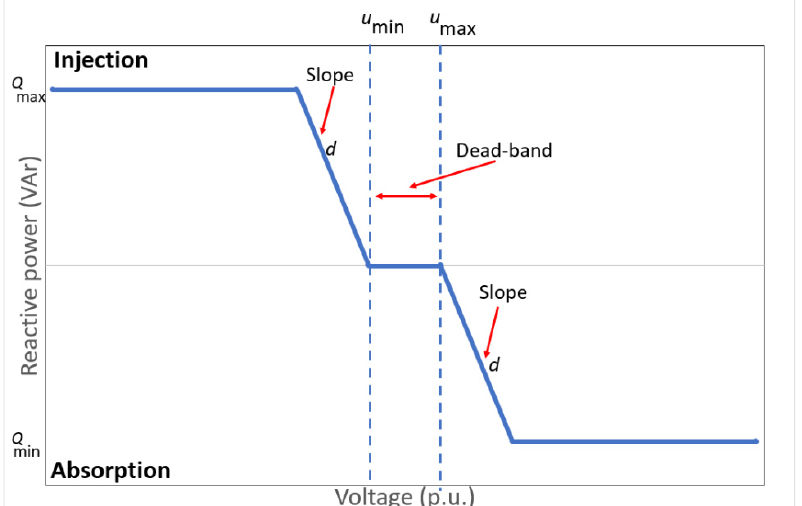
Figure 4. Voltage/Var function requirement for inverters [24] .